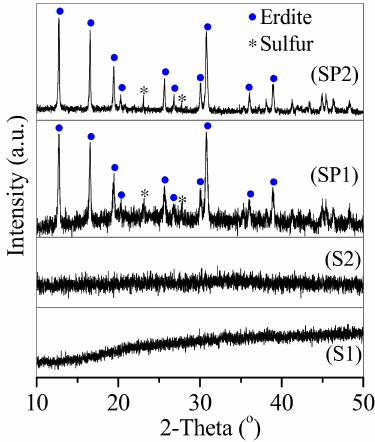
Figure 1. Scanning electron microscope (SEM) images of ( a ) S1, ( b ) S2, ( c ) SP1 and ( d ) SP2.